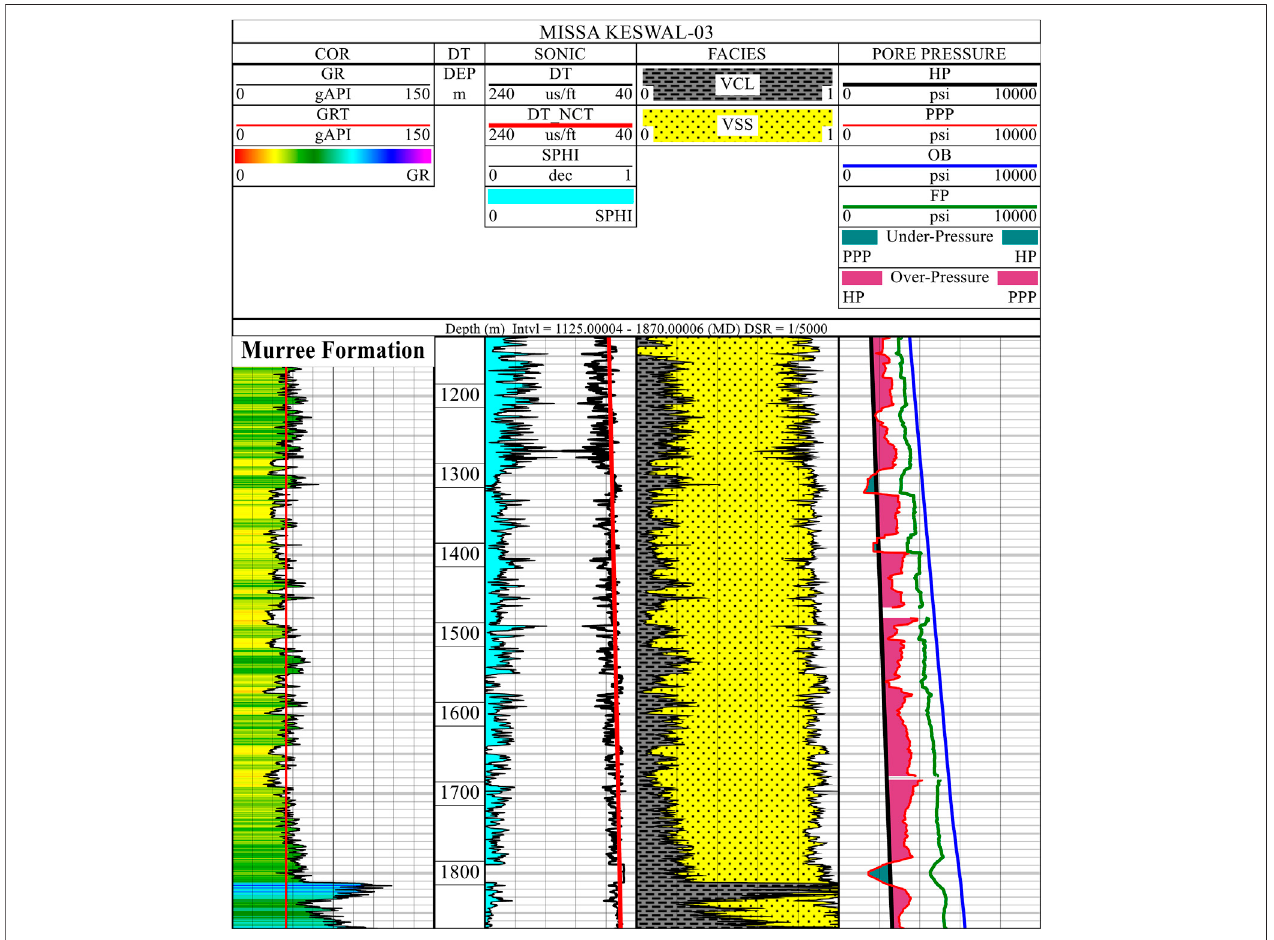
FIGURE 13 | Porosity, facies and predicted pore pressure results in MissaKeswal-03 well. Log plot template for inputdata and computed results is same as used forQazian-1Xwell.MurreeFormationshowconstantsandfacieswithgoodporositiesandoverpressurezonesthroughouttheintervalwithonlyfewlow-pressurezones. FP curve represent relatively easier drilling conditions in the lower part, as its values are signi fi cantly higher than the PPP values.